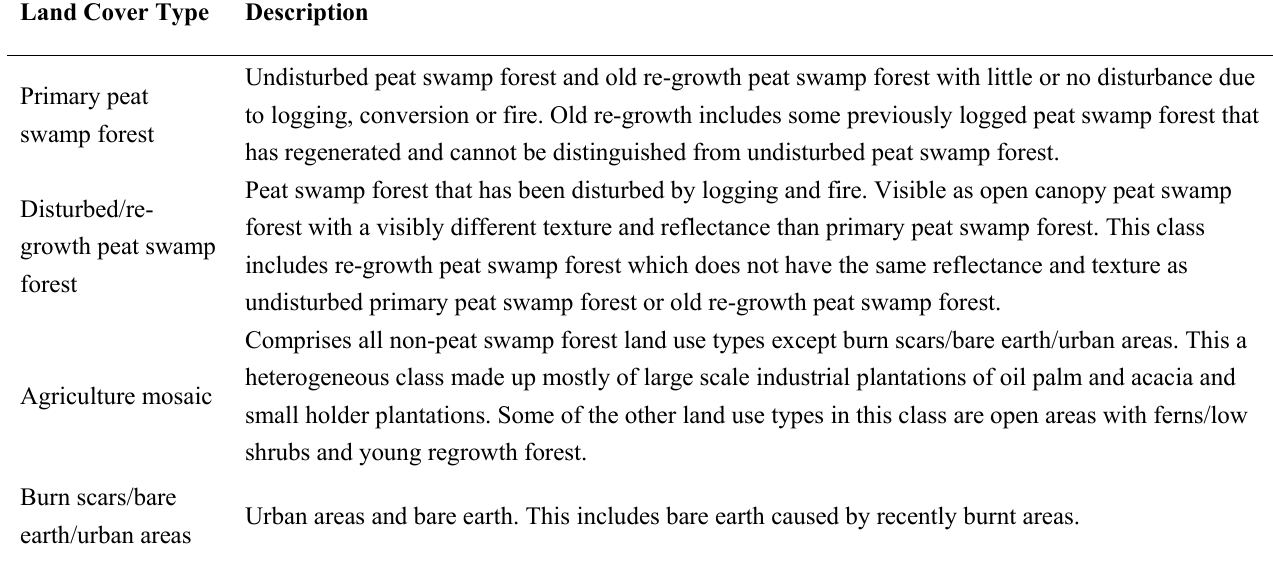
Table 1. Description of land cover types used in our